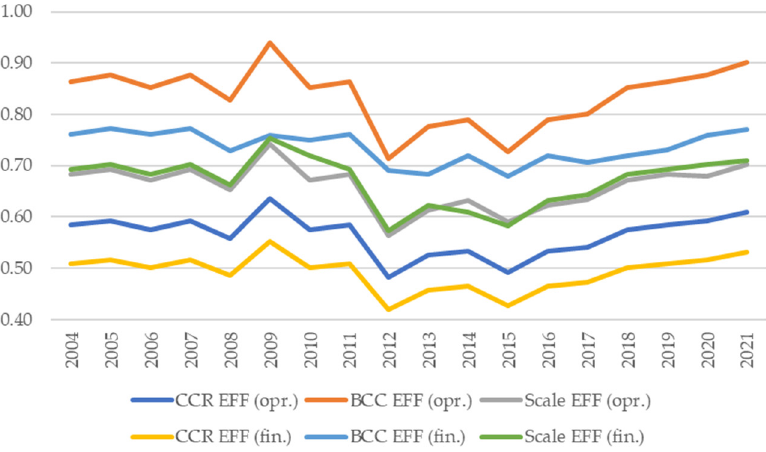
Figure 2. DEA Efficiency Scores.